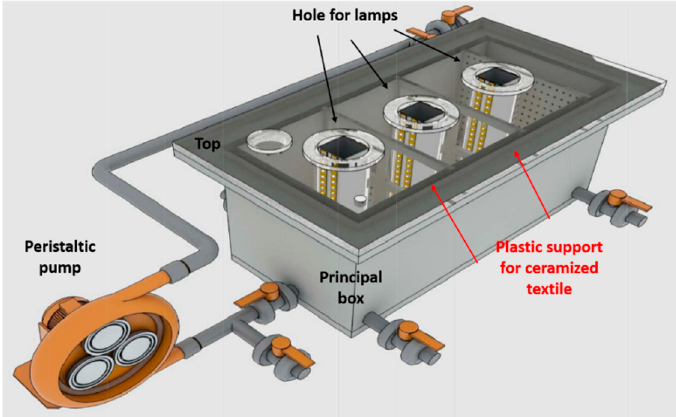
Figure 5. Schematized representation of a 6 L semi-pilot plant.